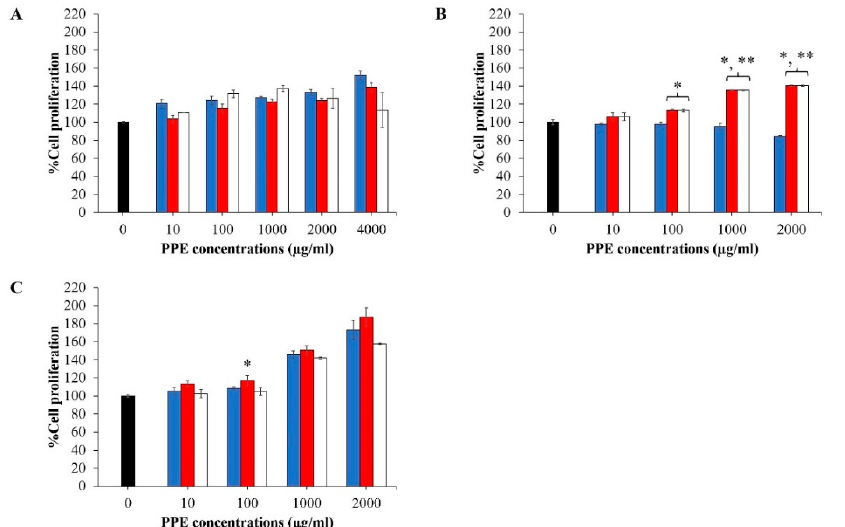
Figure 3. Effect of PPE on the proliferation of ( A ) NHF, ( B ) HaCaT, and ( C ) HFDPC cells. Each cell was treated with various concentrations (0–2000 µg/mL) of PPE for different time intervals: 24 h ( (cid:4) ), 48 h ( (cid:4) ), and 72 h ( ). Data are presented as mean ± SD ( n = 3). * and ** represent the signifi- cant difference in % cell proliferation compared with the cell proliferation at 24 h at p -value < 0.05 and 0.001, respectively.